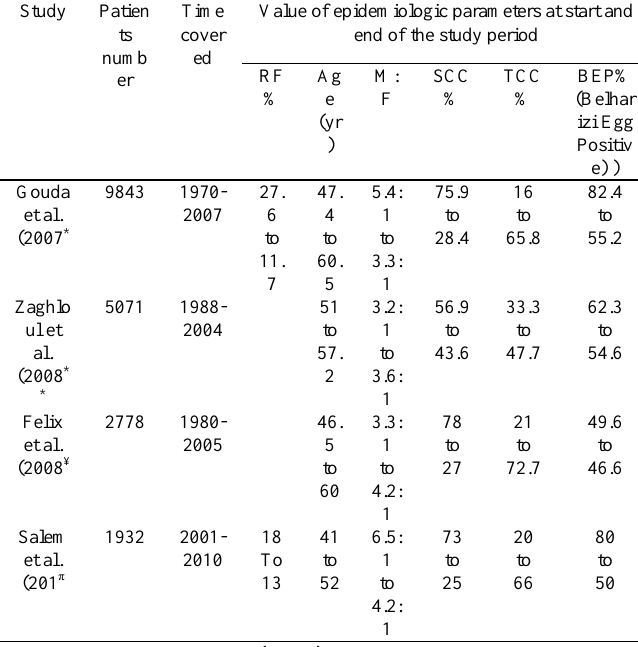
Table 1: The four major studies tracing bladder carcinoma and schistosomaSchistosoma trends